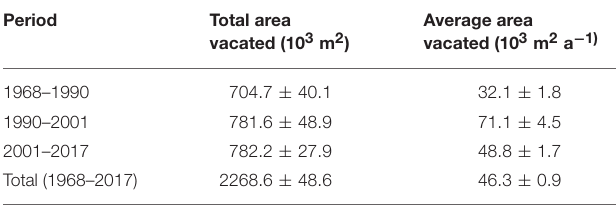
TABLE 3 | Total area vacated as a result of glacier recession.